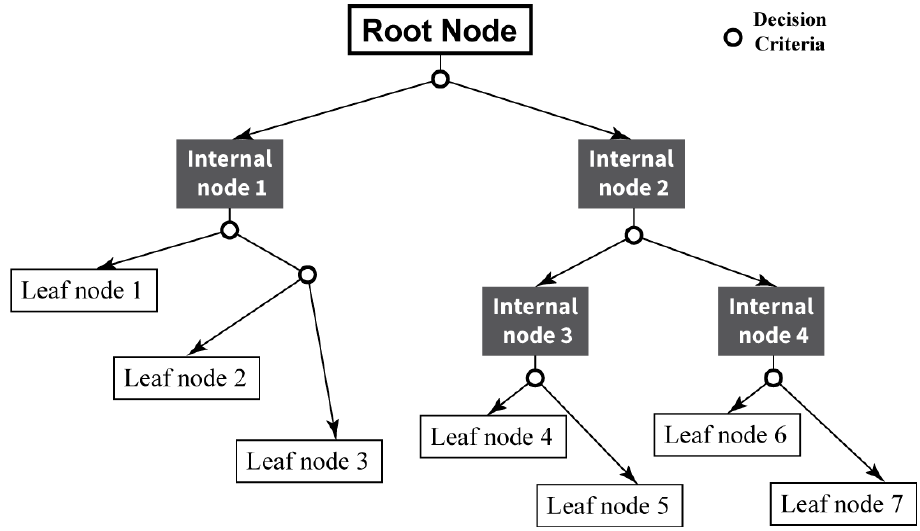
Figure 2. Schematic diagram of a decision tree model.